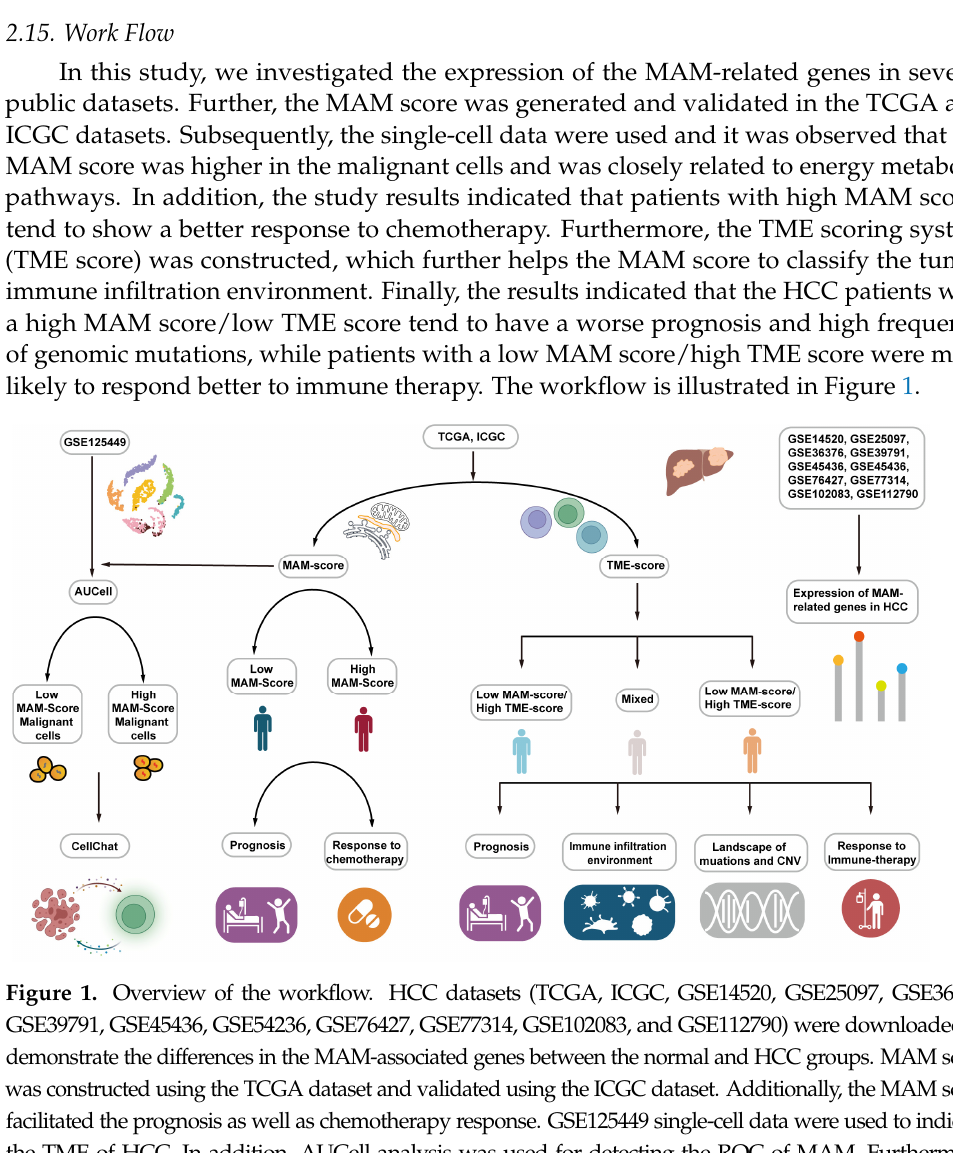
constructed and the samples were classified into three groups based on the MAM and TME scores. Finally, the prognosis, immune infiltration environment, landscape of mutation and CNV, and response to immune therapy of the three groups were